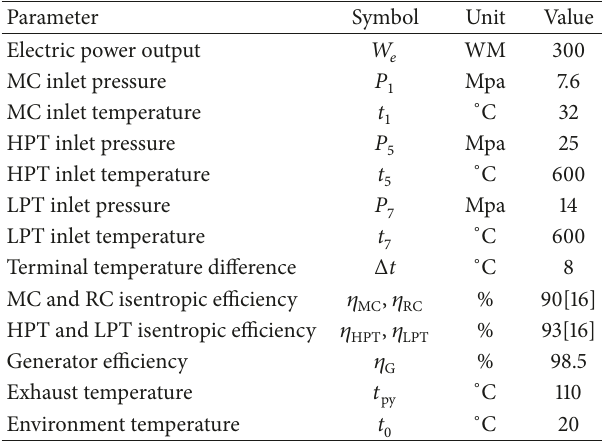
Table 1: Initial parameters.